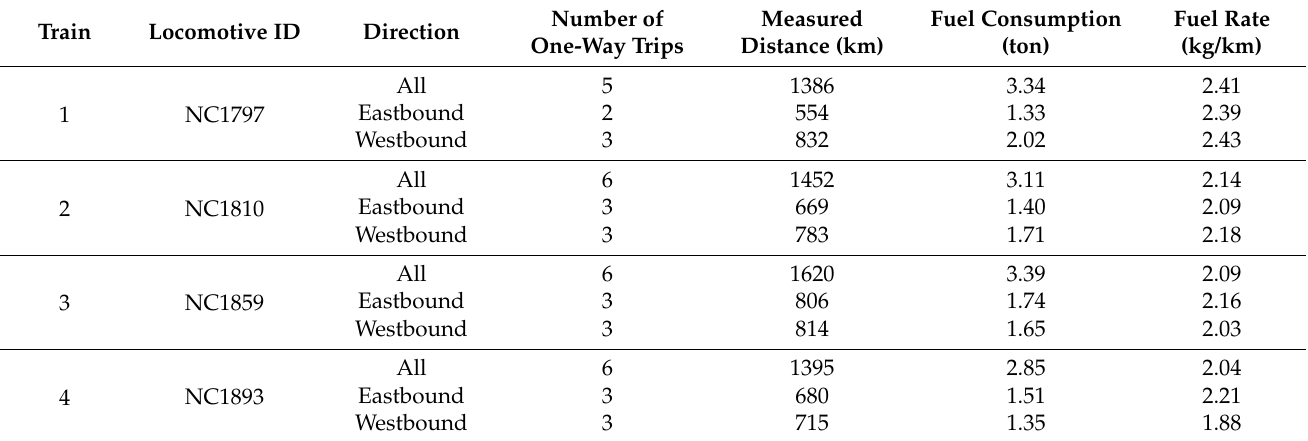
Table 1. Trip data